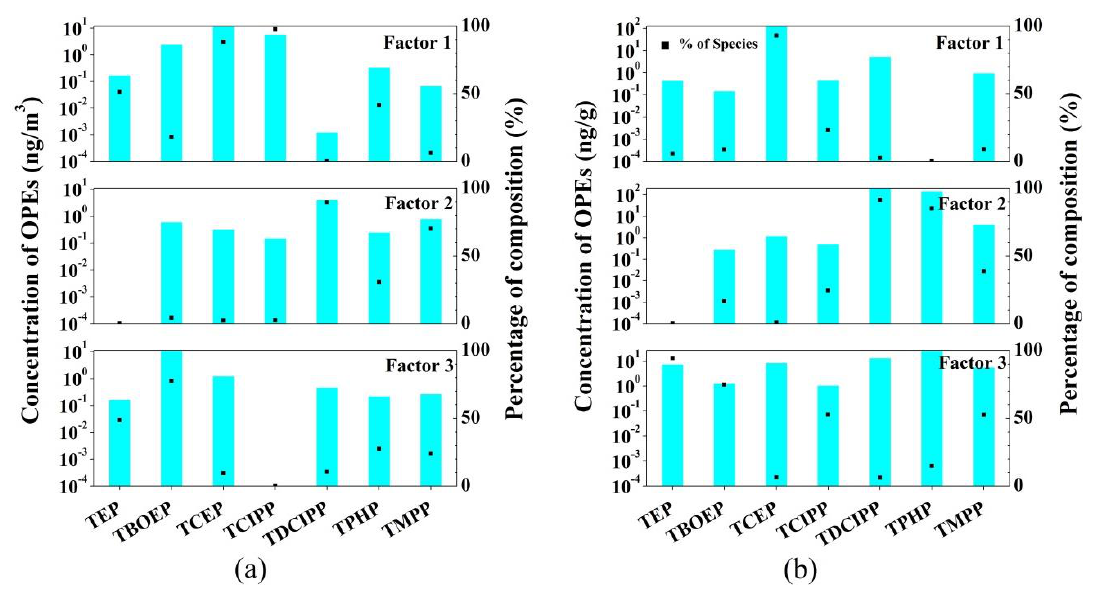
Figure 2. ( a ) The source distribution of OPEs in indoor atmospheric PM 2.5 (left column: contribution of various factors to the concentration of OPEs (ng/m 3 ); right column: impact ratio of various factors on OPEs (%)); ( b ) The source distribution of OPEs in indoor dust (left column: contribution of various factors to the concentration of OPEs (ng/g); right column: impact ratio of various factors on OPEs (%)).